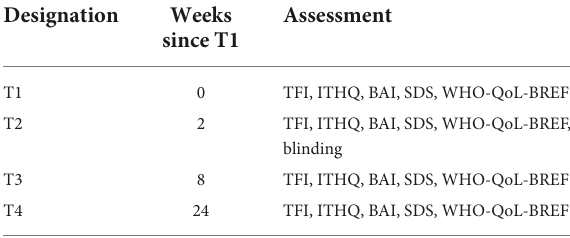
TABLE 3 Assessment points and methods included in